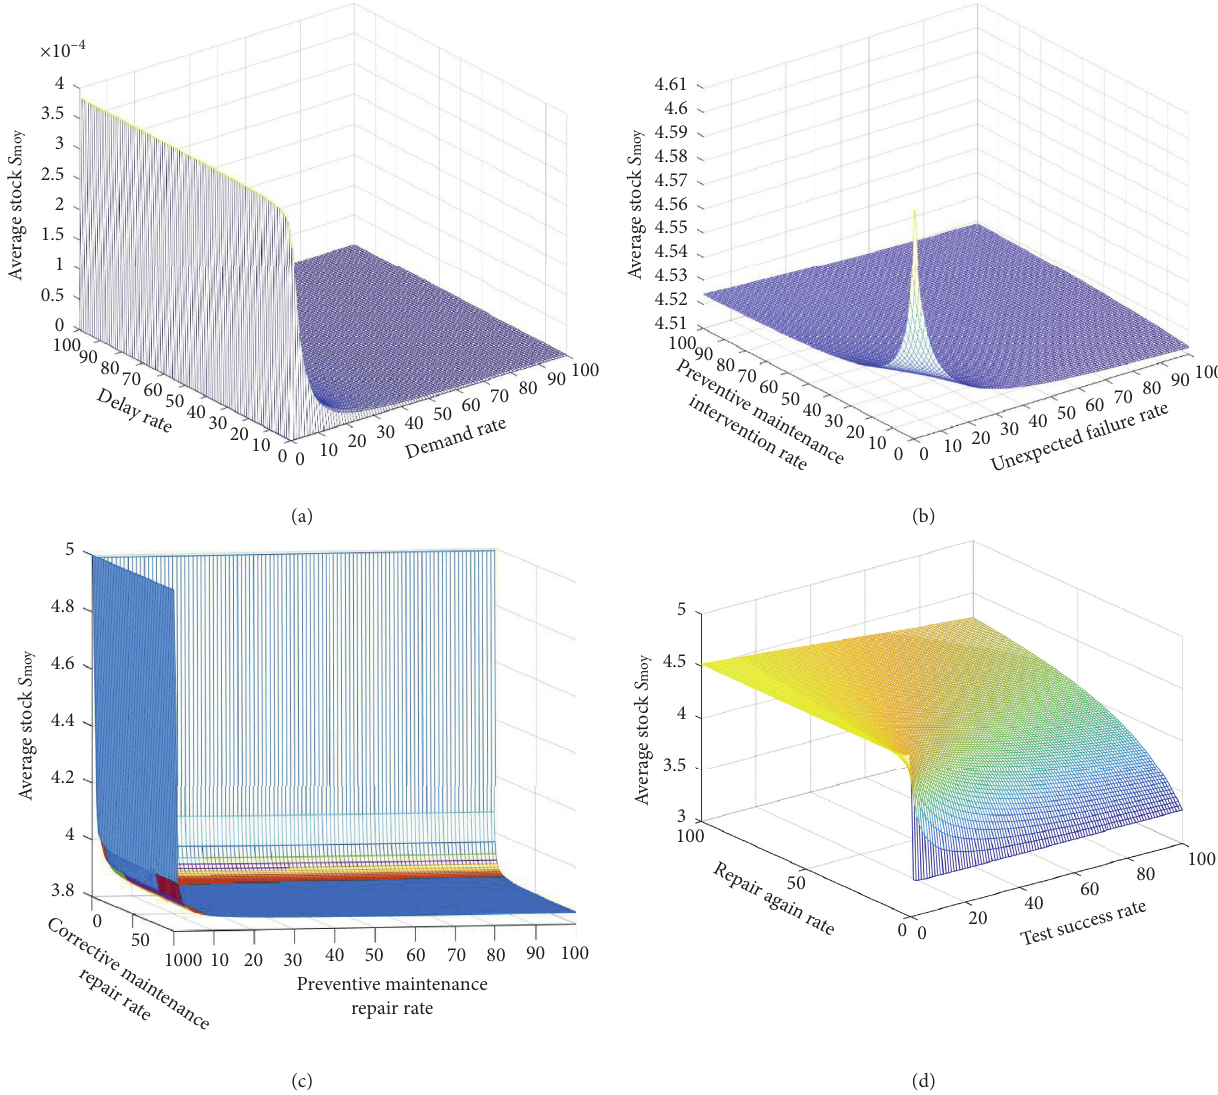
Figure 3: Average stock. (a) Variation of demand and delay rates. (b) Rate variation of unexpected failure and maintenance interventions. (c) Repair rate variation for corrective and preventive maintenance. (d) Test rate variation (repair again or